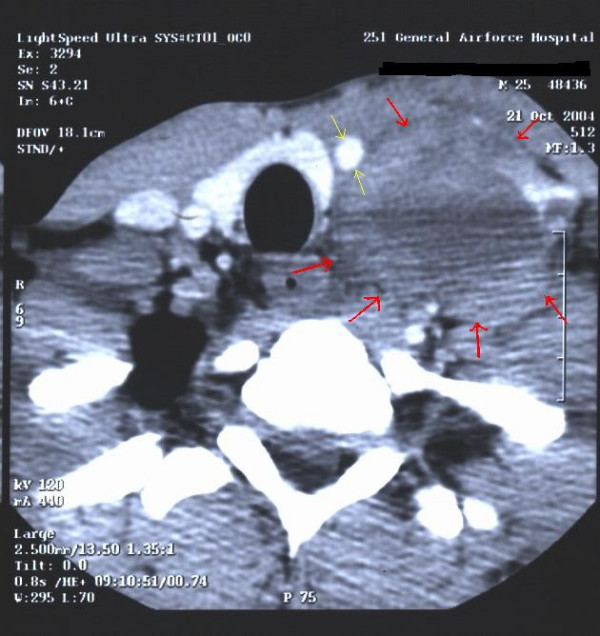
CT scan of the cervix revealing a large mass (red arrows), 14 cm in greatest diameter extending from the left carotide triangle to the anterior-posterior mediastinum, in proximity with the great vessels of the heart, dislocating the left common carotid artery (yellow arrows) and the left vagus nerve without infiltrating them.